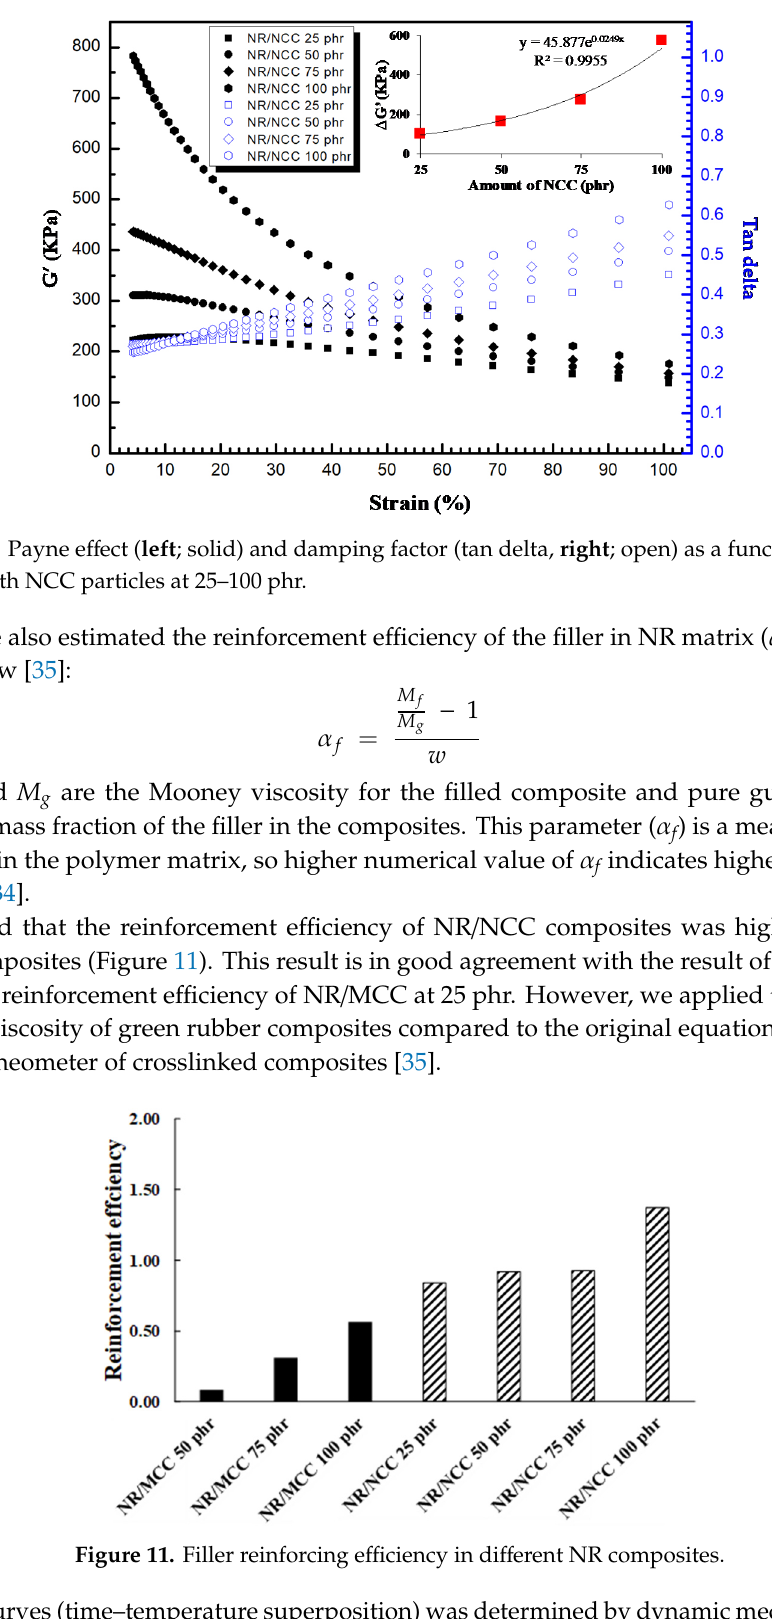
Figure 9. Payne effect ( left ; solid) and damping factor (tan delta, right ; open) as a function of strain Figure 25. phr.